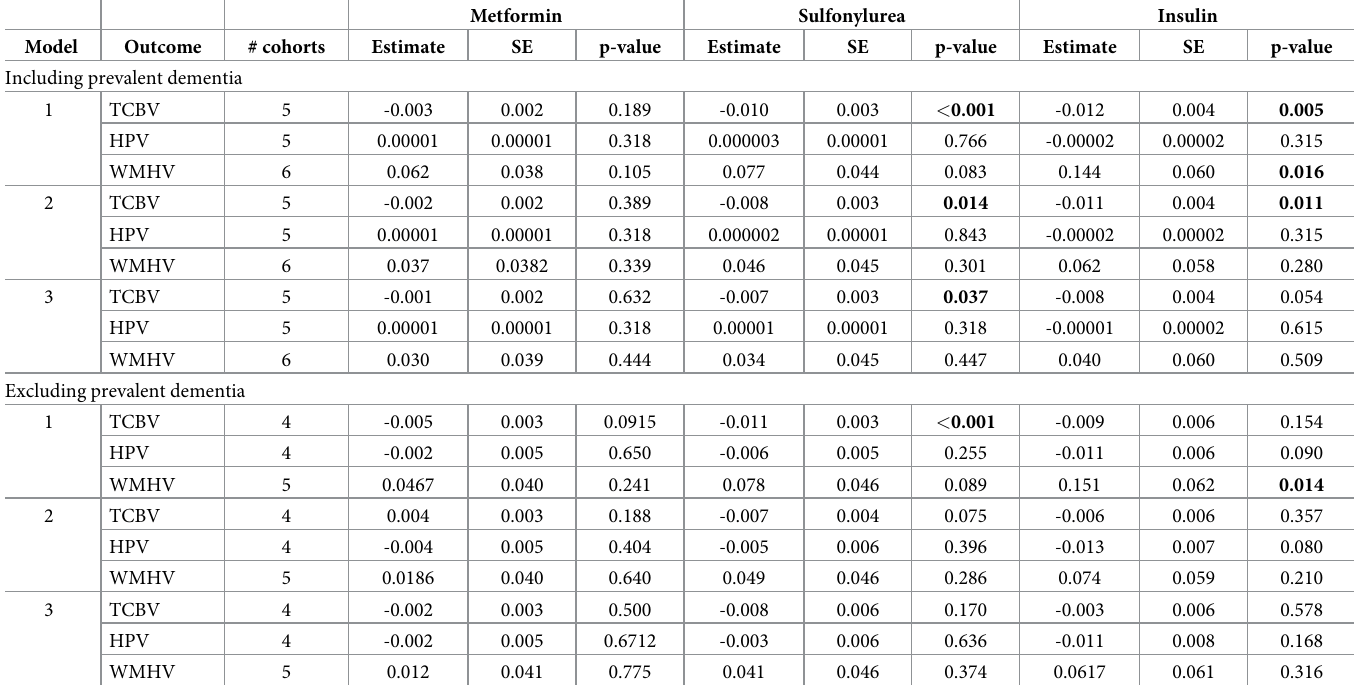
Table 5. Associations of diabetes drug classes (single or in combination) with brain MRI measures among individuals with diabetes- Fixed effects